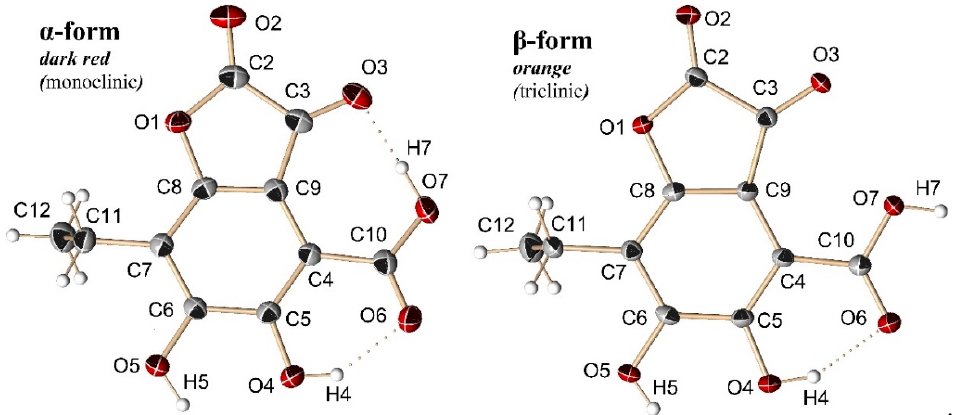
Figure 6. Molecular structure of echinolactone ( 11 ) in different crystal types (hydrogen bonds are shown as dotted lines).